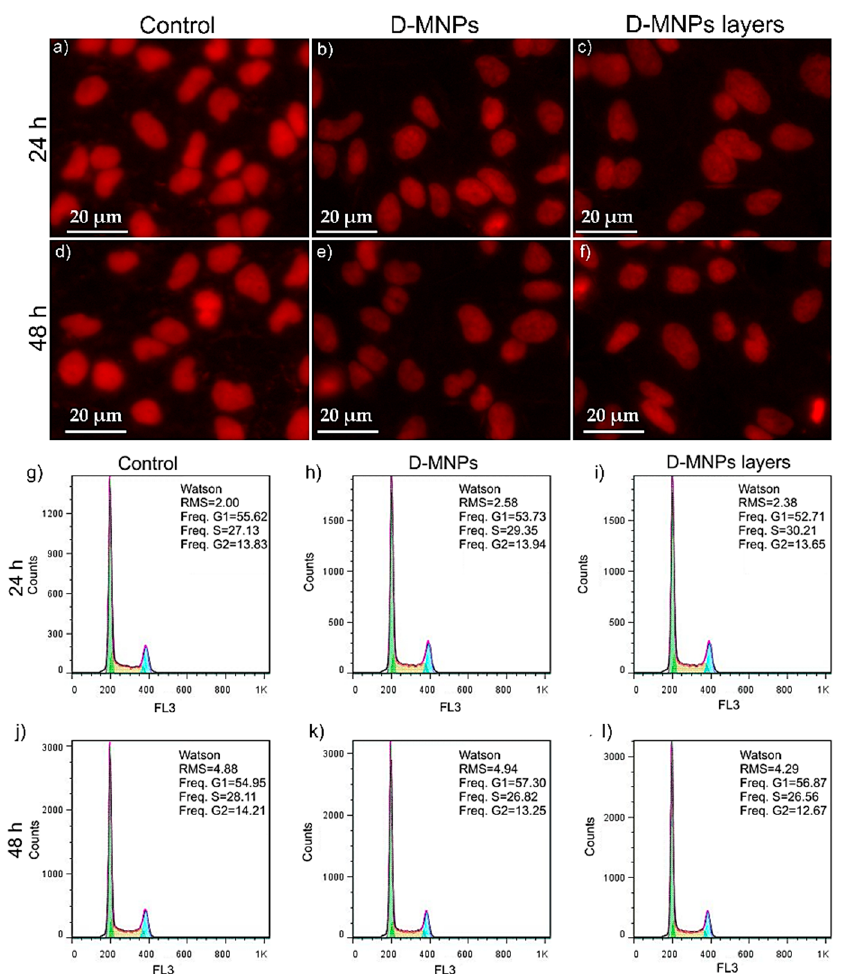
Figure 8. The morphology of the HeLa cells incubated with the D-MNP suspension ( b ) and D-MNP layers ( c ) at 24 h, relative to the control ( a ). The morphology of the HeLa cells incubated with the D-MNP suspension ( e ) and D-MNP layers ( f ) at 48 h, relative to the control ( d ). The cell cycle histogram analysis of HeLa cells incubated with D-MNP suspension ( h ) and D-MNP layers ( i ) at 24 h, relative to the control ( g ). Cell cycle analysis of the HeLa cells incubated with the D-MNP suspension ( k ) and D-MNP layers ( l ) at 48 h, relative to the control ( j ).